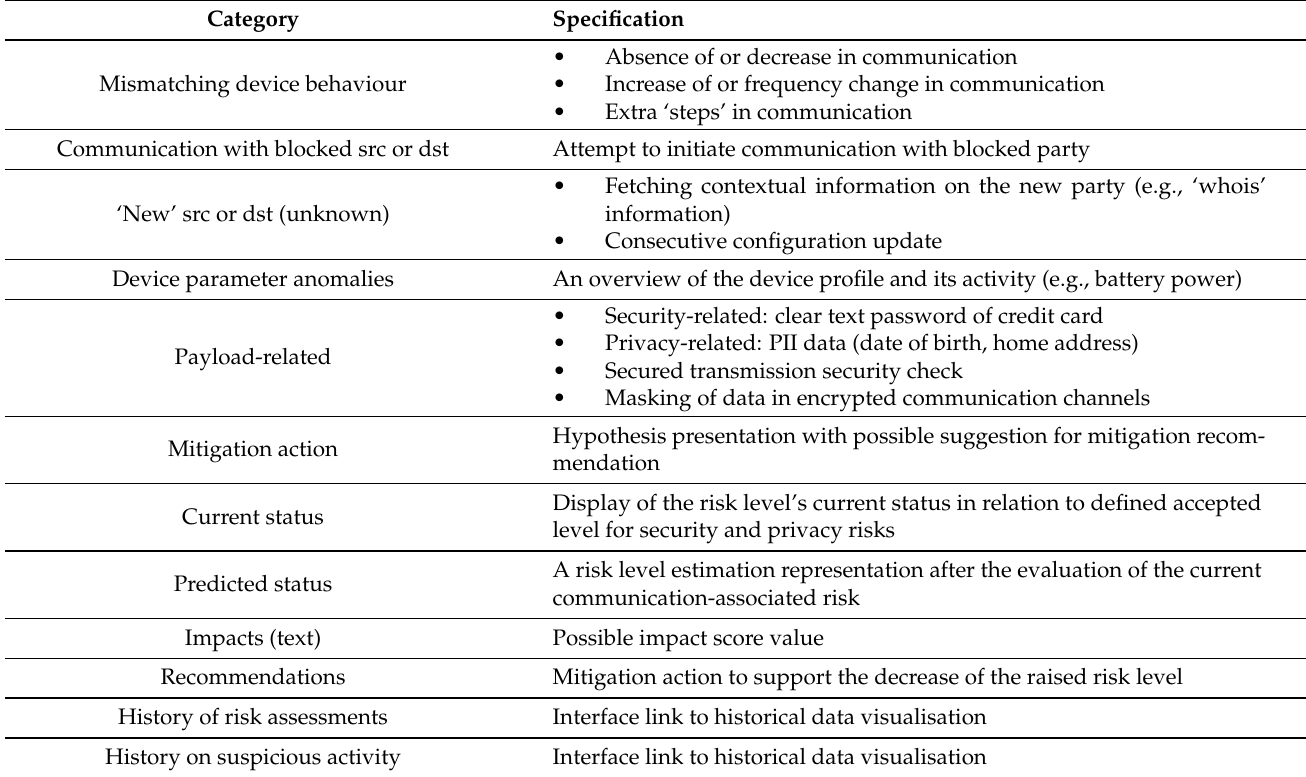
Figure 11. Security preferences. Table 12. Security intervention: interaction